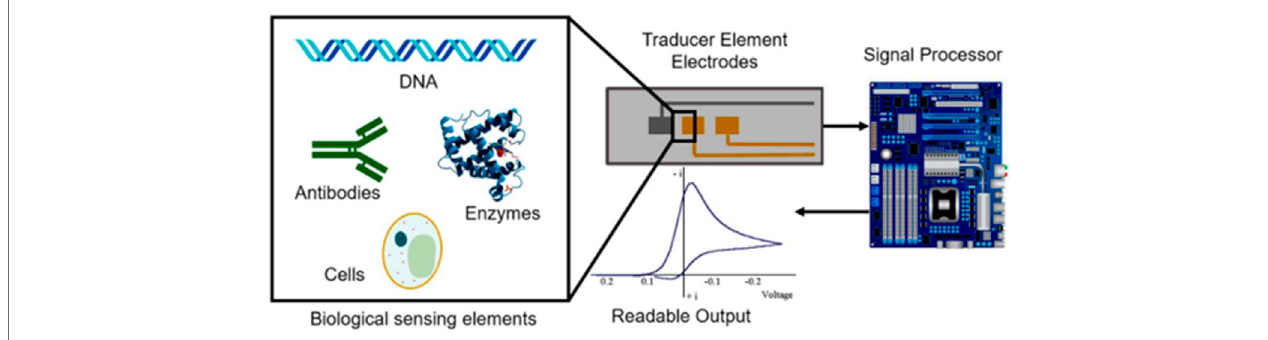
FIGURE 2 | Scheme of an electrochemical biosensor.